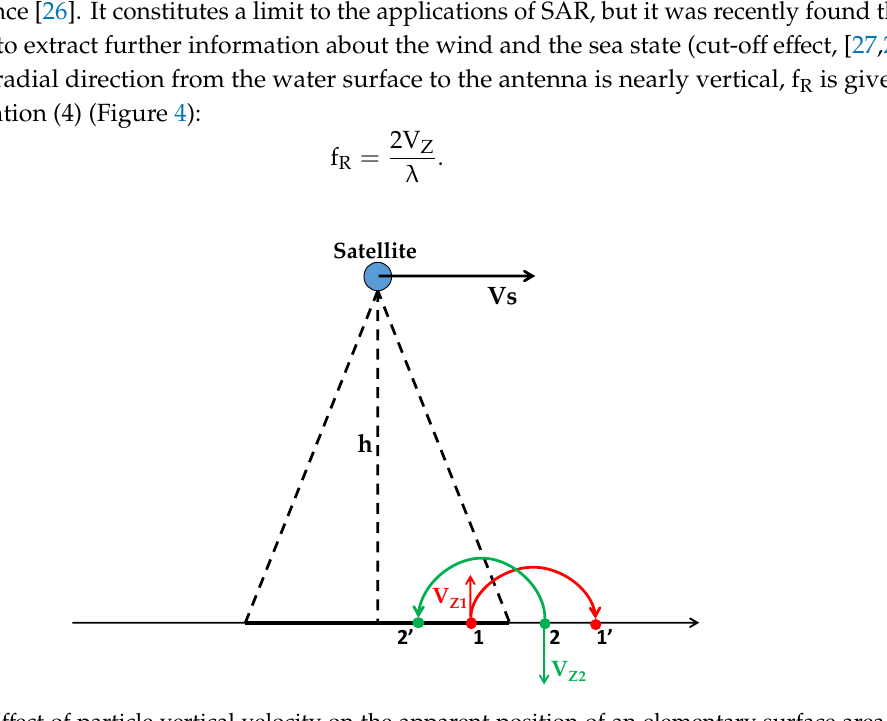
Figure 4. Effect of particle vertical velocity on the apparent position of an elementary surface area. The red point, positioned in 1, has a positive vertical velocity component V Z1 , which adds to its Vc; it therefore appears to be farther (position 1’) from the nadir; the green point, positioned in 2, has a negative V Z2 ; it therefore looks closer (position